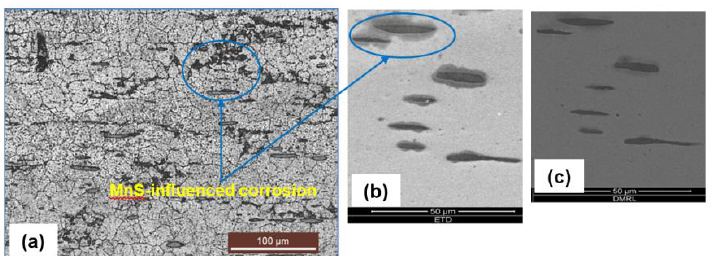
Figure 7: (a,b,c) Optical, SEM SE and SEM BSE micrographs respectively showing MnS stringer influenced corrosion along the stringer-matrix interface.